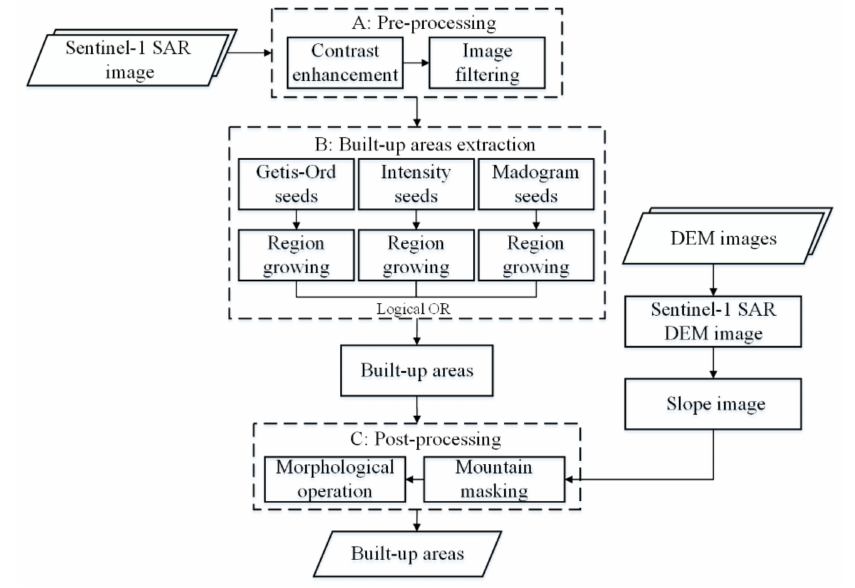
Figure 1. Framework of the proposed BAs extraction